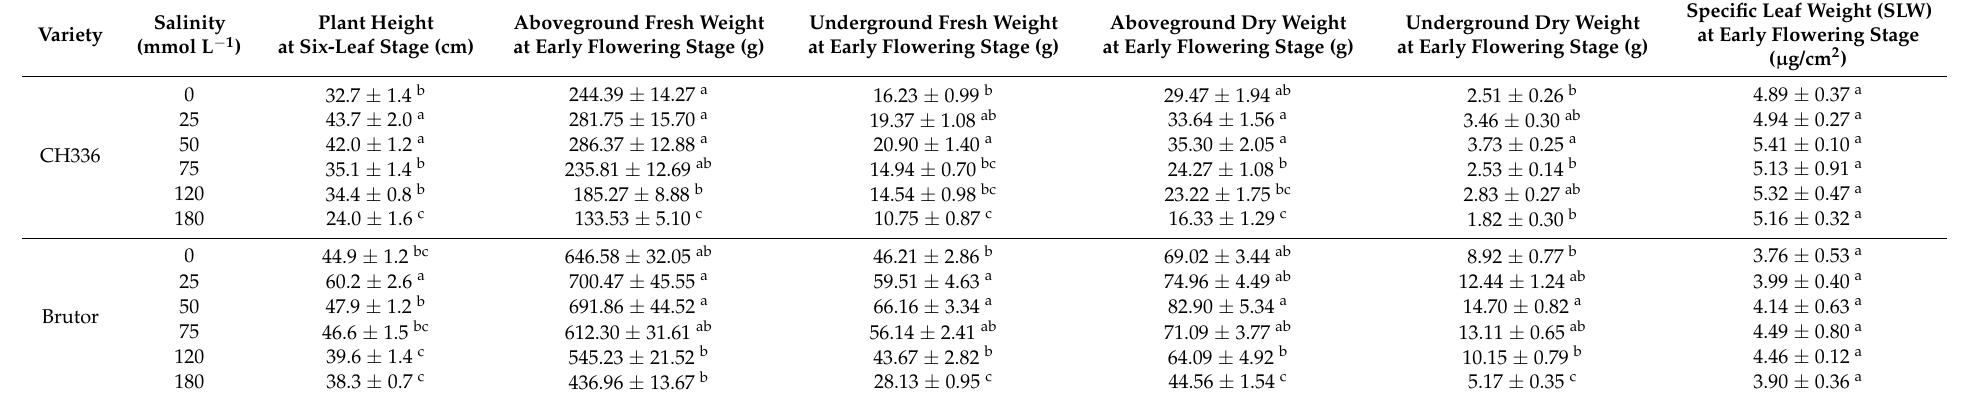
Table 1. Effects of different salinity levels on the seedling growth parameters of two Brassica napus varieties, CH336 (semi-winter type) and Brutor (spring type), in pot